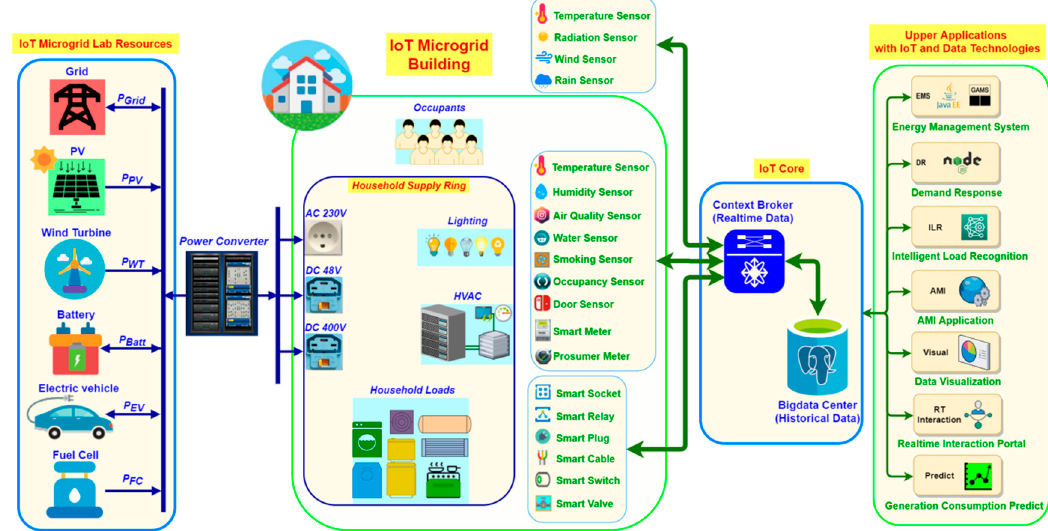
Figure 8. Infrastructure of IoT-enabled microgrid with intelligent building for energy digitalization.